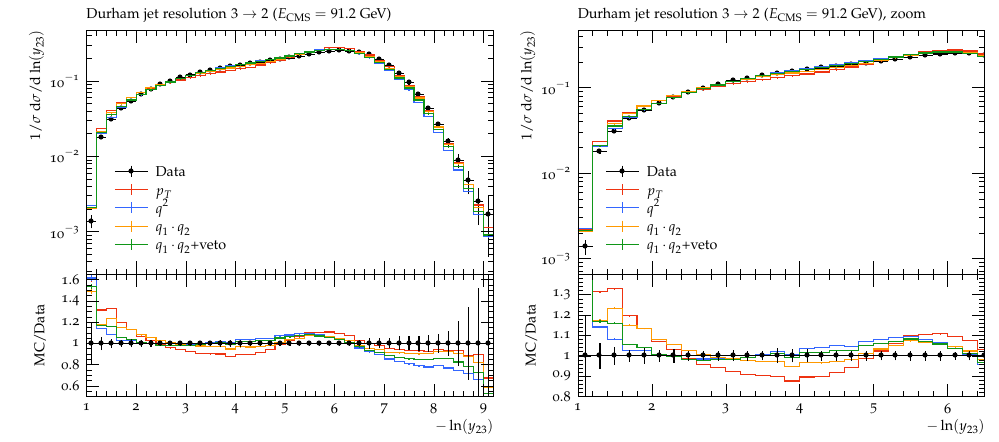
Figure 7 . Jet resolution parameter from a 3-jet con(cid:12)guration to a 2-jet con(cid:12)guration at the Z-pole compared with data from the ALEPH [47] experiment. In the right panel an expanded section of the same plot is